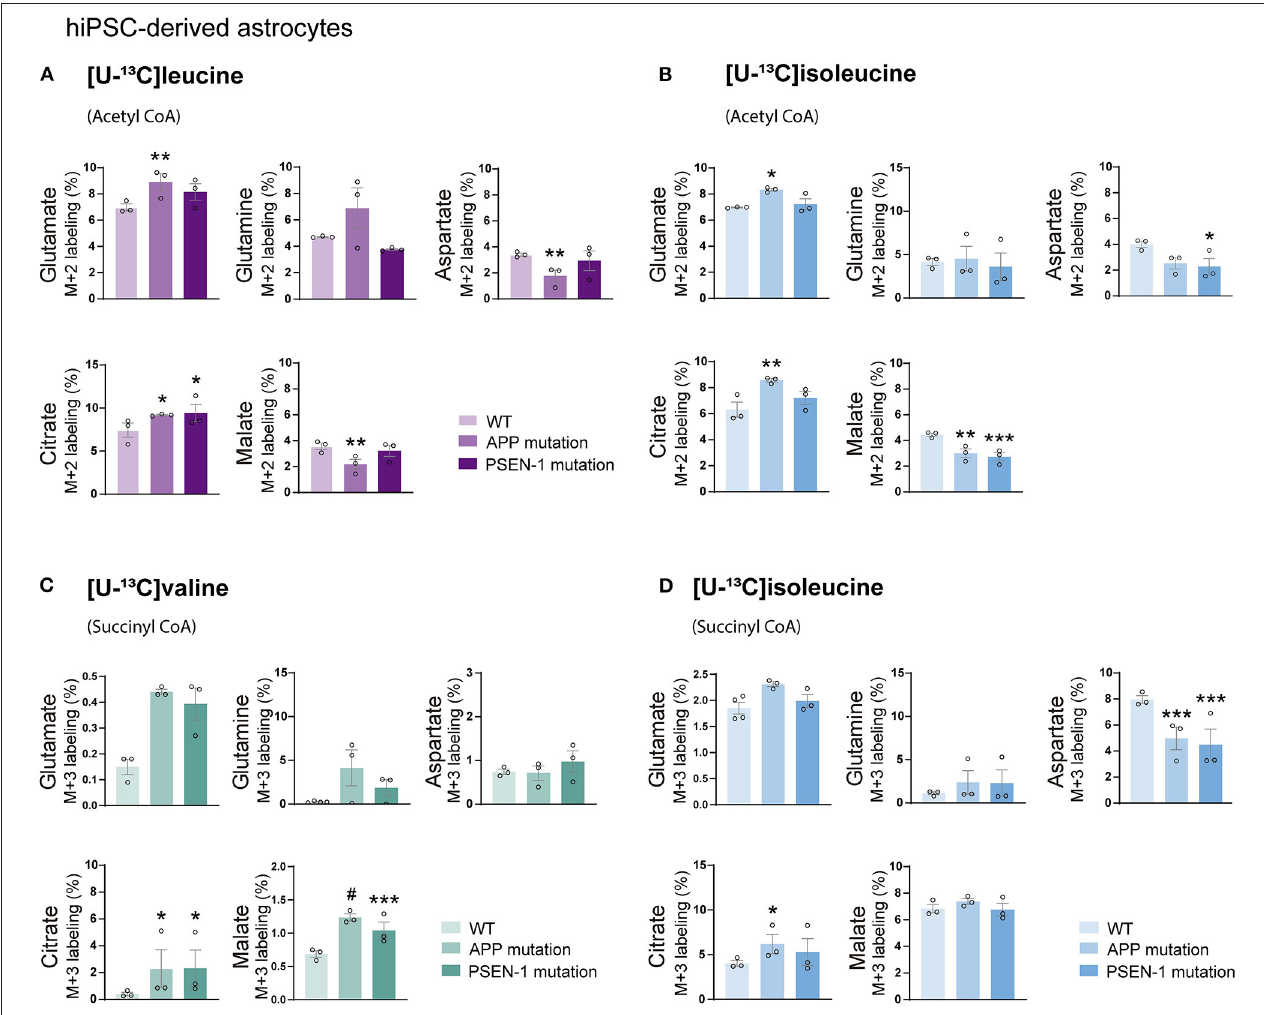
FIGURE 5 | Reduced oxidative BCAA metabolism entering as acetyl CoA in Alzheimer’s disease (AD) astrocytes. (A) Increased glutamate and citrate M + 2 labeling but decreased aspartate and malate 13 C-enrichment after incubation with [U- 13 C]leucine and (B) [U- 13 C]isoleucine in human AD astrocytes when entering via acetyl CoA. (C) Increased TCA cycle metabolites M + 3 labeling after incubation with [U- 13 C]valine but (D) decreased aspartate 13 C-enrichment after incubation with [U- 13 C]isoleucine in human AD astrocytes when entering via succinyl CoA. Values represent mean ( ± ) SEM ( n = 3), * p < 0.05, ** p < 0.01, *** p < 0.001, # p < 0.0001, analyzed by two-way ANOVA. WT, wild type; APP, amyloid precursor protein; PSEN-1, presenilin-1.